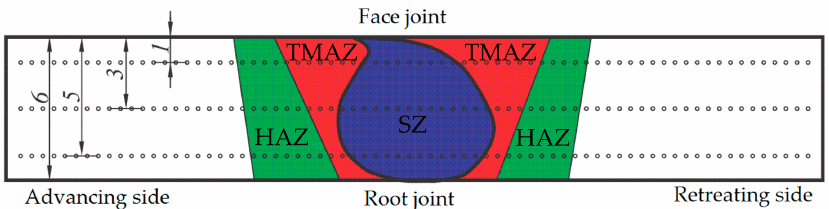
Figure 3. Microhardness measurement scheme with characteristic zones of welded joint (SZ—stirred zone, TMAZ—thermomechanical affected zone, HAZ—heat affected zone).